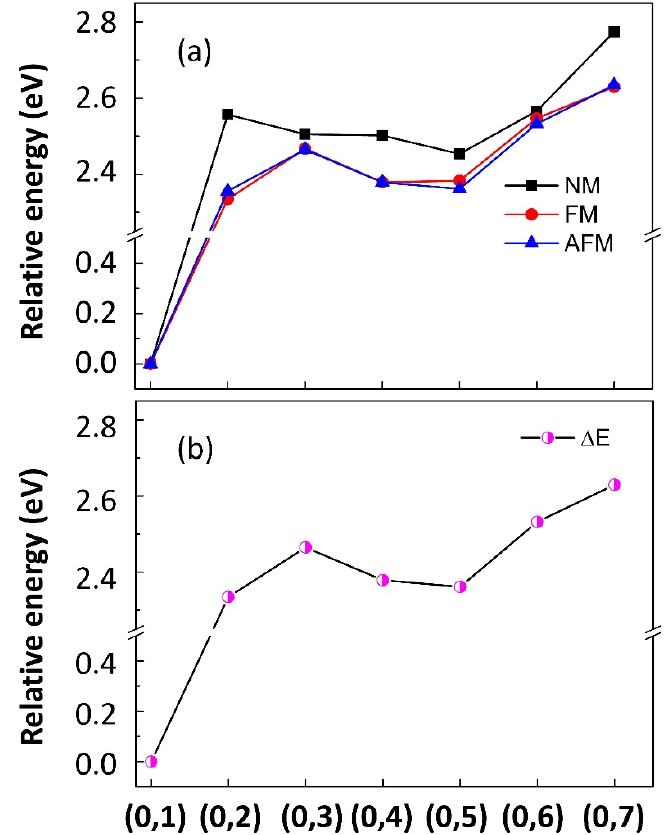
Figure 2. Panel ( a ): Calculated relative energy (eV/dopant) in nonmagnetic (NM), ferromagnetic (FM) and antiferromagnetic (AFM) states. Panel ( b ): Relative energy (eV/dopant) of different (0,j) structures for the B doped SrTiO 3 system. The lowest energy is set as a reference, i.e., ∆ E = E (0,j) − E (0,1) for each structure. Table 1. Relaxed distance between two foreign B atoms (R d (Å)), relative energy ( ∆ E, in units of eV/dopant), energy difference between FM and AFM states (E MM , in units of eV/dopant), total magnetic moment (MM tot ), localized magnetic moment on boron (MM B ), and average contribution to